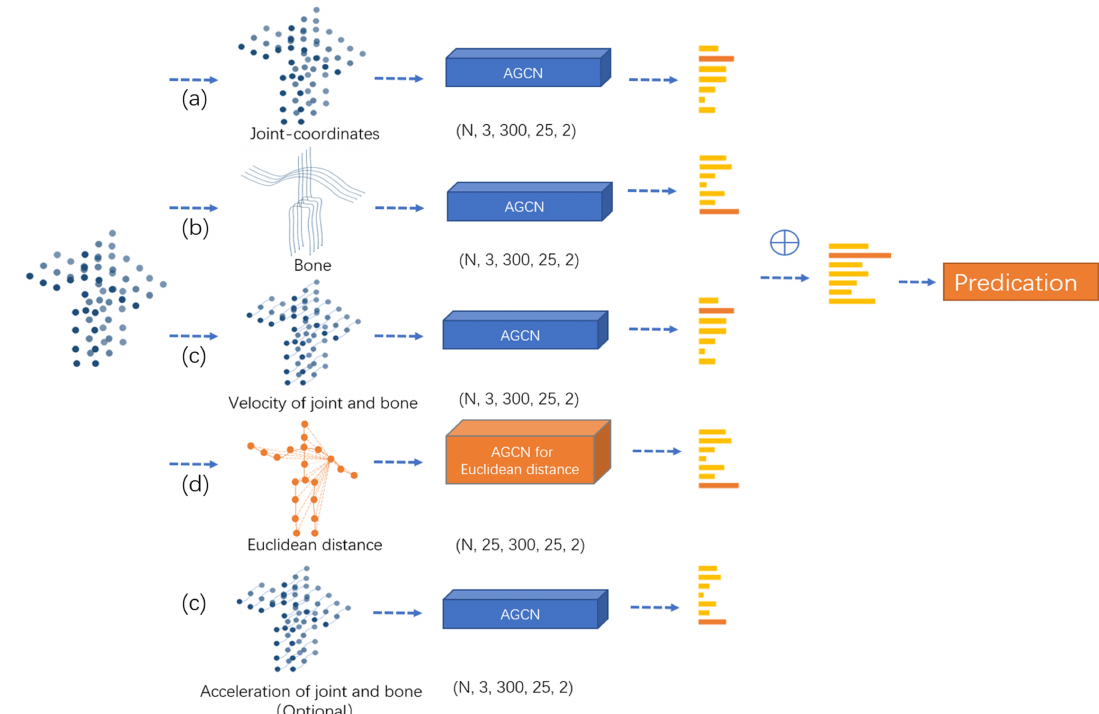
Figure 2. Illustration of the overall architecture of the MS-AGCN. The structure of the AGCN in blue is the same. The only difference between blue and orange is the number of input channels. The final score to obtain the prediction. The shape of input data is presented. ( a ) The joint feature, which is extracted from 3D coordinates of all joints. ( b ) The bone feature, which contains edge information. ( c ) The velocity feature and the acceleration feature, which are calculated from consecutive frames to obtain the temporal feature. ( d ) The relative distance feature of 3D joints; each joint contains relative distance information from others, and we only use one joint as an illustration in the